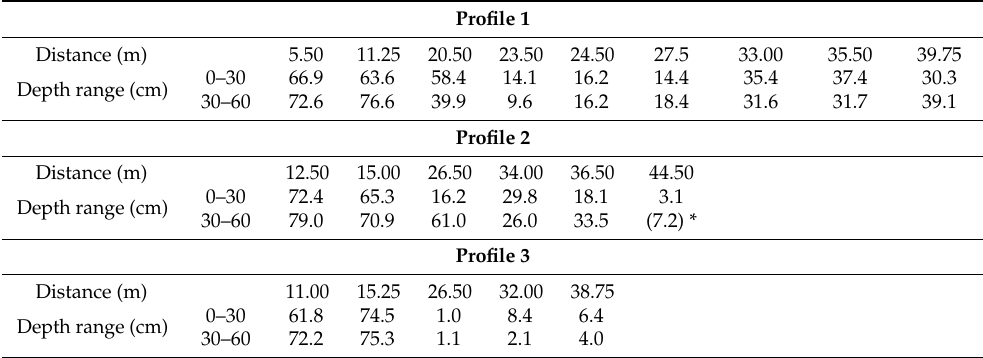
Table 1. Coarse grain fraction percentage in soil samples (>2 mm). Distances from the beginning of each ERI